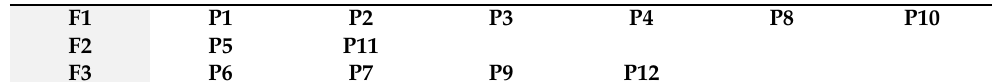
Table 7. Final Groups Based on